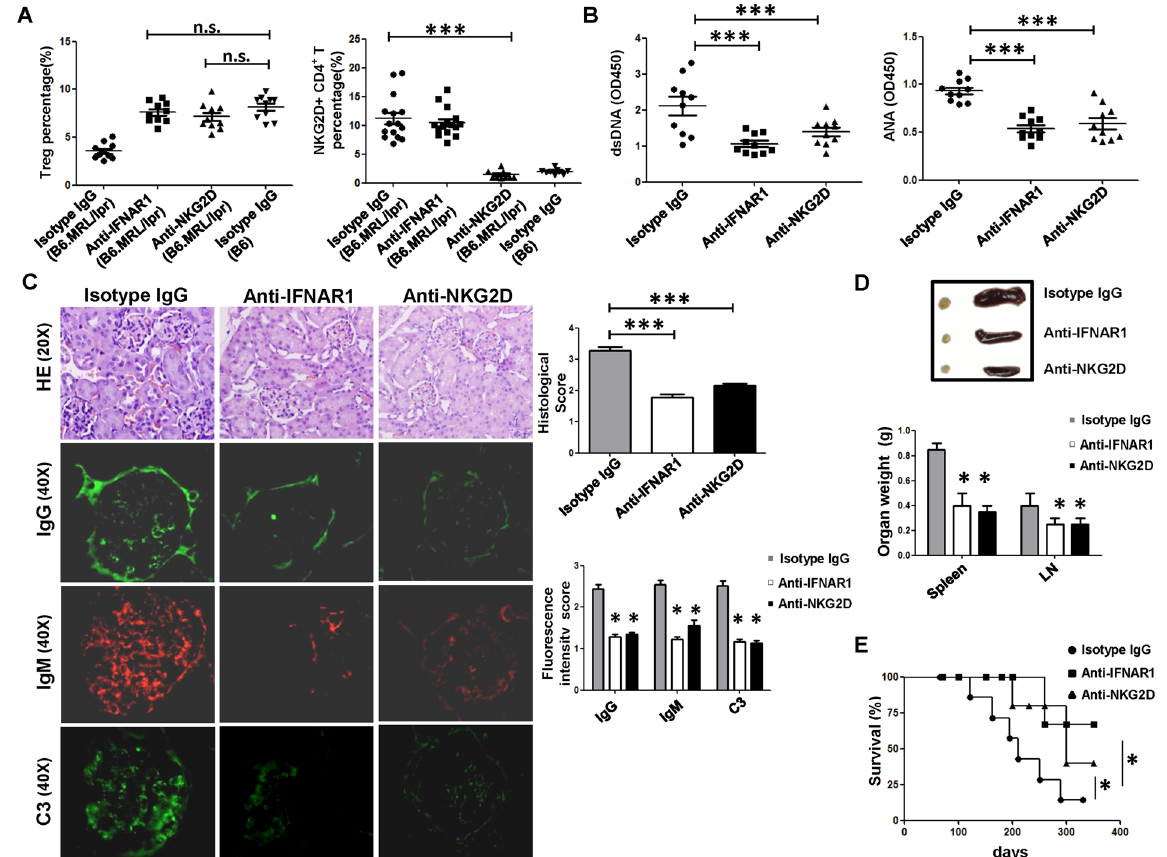
Figure 6. Anti-IFNAR mAb and anti-NKG2D mAb treatment ameliorated lupus disease in B6.MRL/lpr mice. ( A ) Comparison of the frequencies of Treg cells and NKG2D + CD4 + T cells in B6.MRL/lpr mice after 5 wk of IFNAR and NKG2D antibody treatments, as well as in healthy B6 control mice. ( B ) Serum level of autoantibodies (anti-dsDNA and ANA) after IFNAR and NKG2D antibody treatments in B6.MRL/lpr mice. Data in A and B are presented as mean ± SD. ( C ) Kidney histology (left) showing reduced glomerular hypercellularity and immune deposits (IgG, IgM and C3) after IFNAR and NKG2D antibody treatments in B6.MRL/lpr mice. Histological score and fluorescence intensity score (right) were assessed. Results are representative of three experiments with 5–6 mice per group. ( D ) Weights of spleen and lymph nodes (LN) after IFNAR1 and NKG2D antibody treatments in B6.MRL/lpr mice. Data are presented as mean ± SD. ( E ) Survival analysis for the IFNAR and NKG2D antibody treatments in B6.MRL/lpr mice, as compared with PBS treatment. Each symbol represents one individual, and data are representative of three independent experiments. * P < 0.05, ** P < 0.01, *** P <